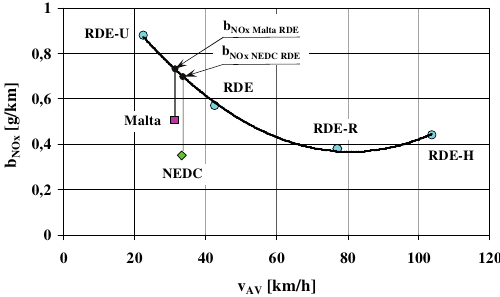
Fig. 21. Schematic for determining the approximate characteristic value from the results of RDE, RDE-U, RDE-R and RDE-H tests for mean vehicle speed equal to the mean speed in the NEDC and Malta tests